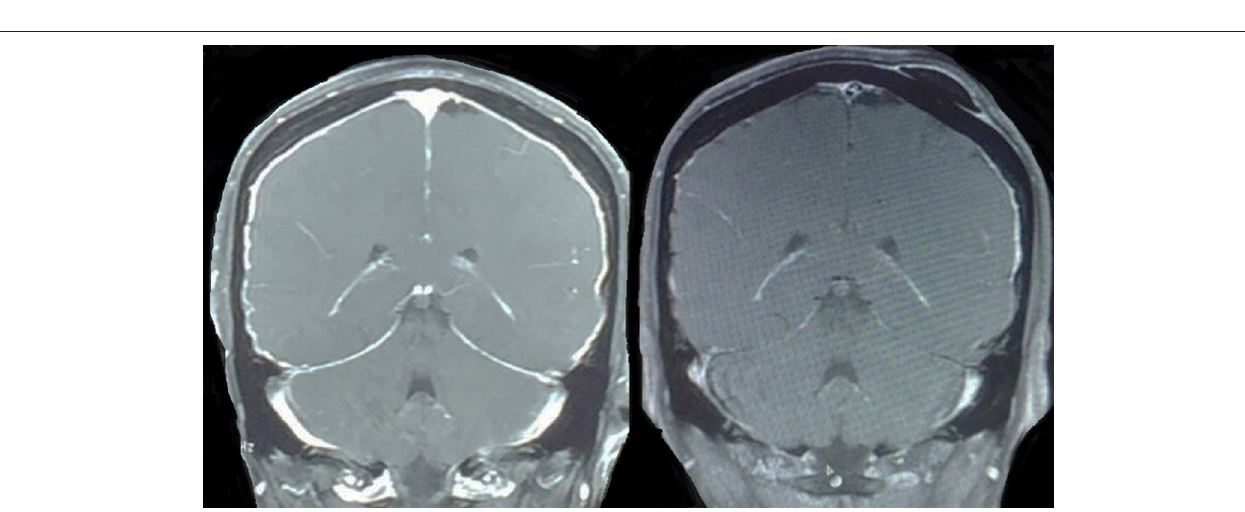
FIGURE 3 | The Overall Survival by Lumbar chemotherapy vs. Intraventricular with Ommaya reservoir in patients with Leptomeningeal Carcinomatosis.